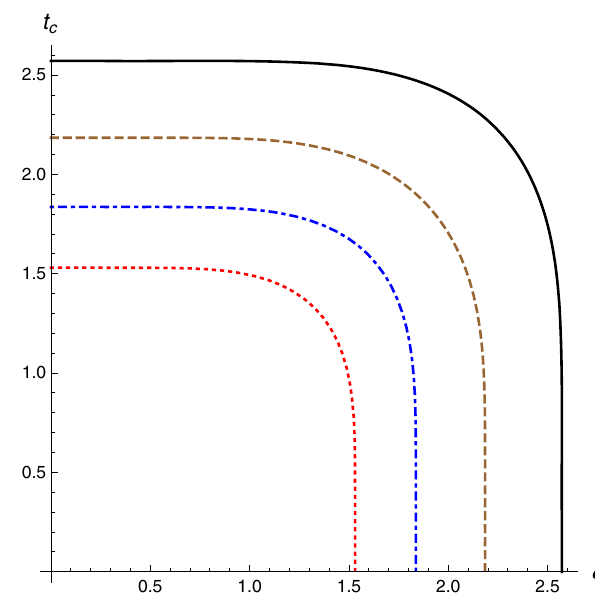
Fig. 2 Reduced critical temperature, t c , as a function of the reduced inverse size of the system, ξ , for a vanishing chemical potential, γ = 0 . 0, fixed λ = 1 . 0, and some values of the magnetic field: δ = 0 . 0; 0 . 3; 2 . 0; and 7 . 0, full , dashed , dotdashed and dotted lines , respectively